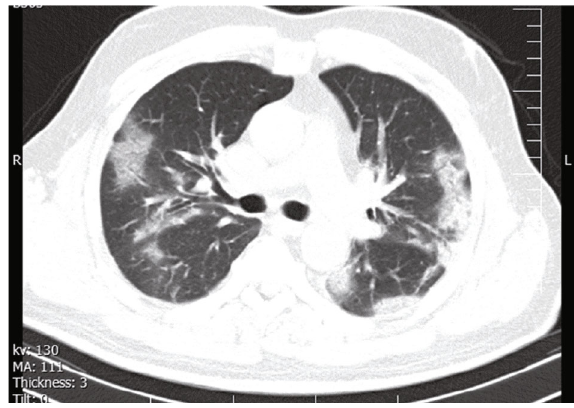
Figure 1: Axial chest CT image without contrast administration showed areas of ground-glass opacities and bilateral consolidations with the predominantly peripheral